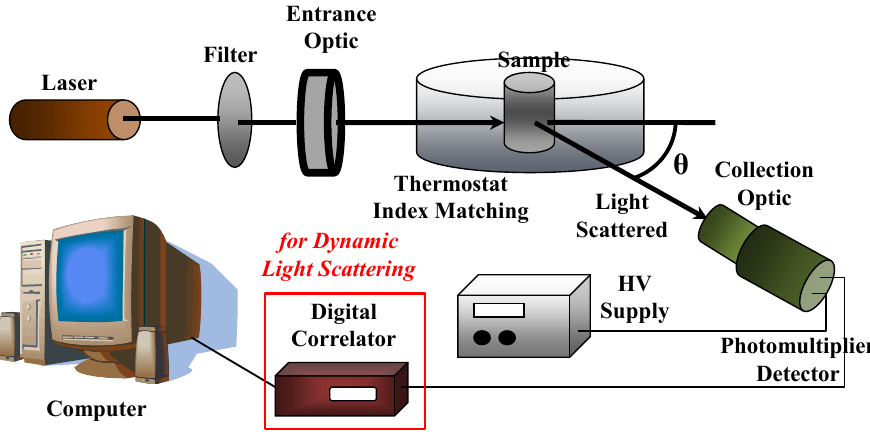
Figure 12. Sketch of a (static and dynamic) light scattering setup.